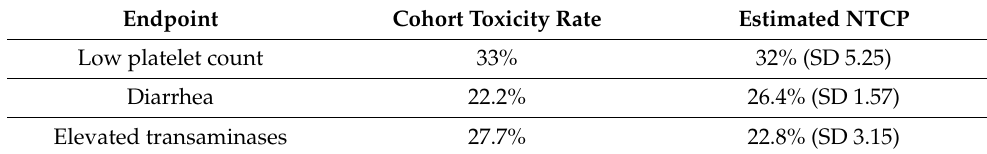
Table 4. Cohort toxicity rates vs. estimated NTCP.